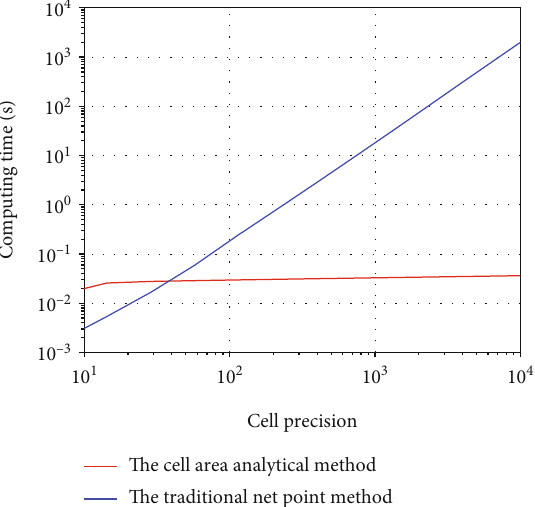
Figure 10: Comparison of the computing time from two algorithms with di ff erent precision for target-1.